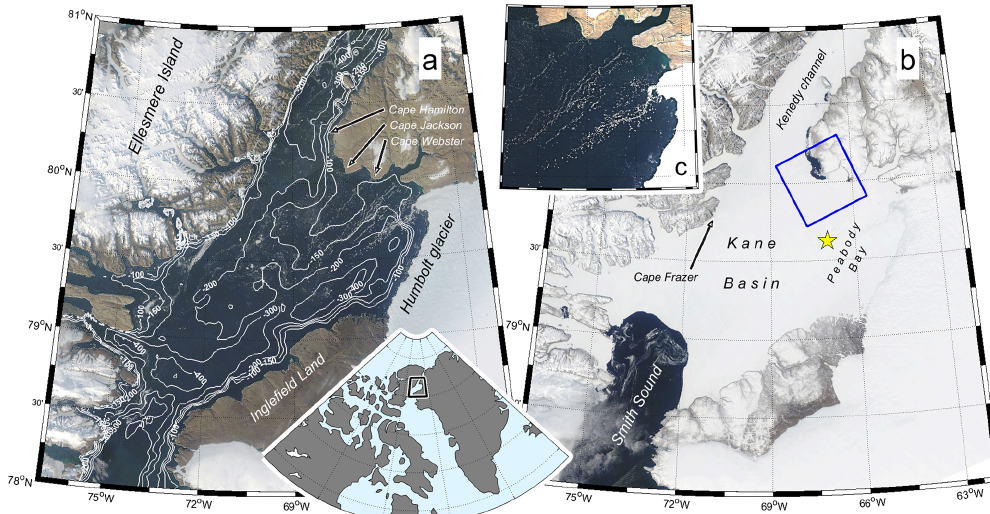
Figure 1. (a) The bathymetry of the central part of Nares Strait with contours corresponding to 100, 150, 200, 250 and 300m isobaths overlaying on the true-color MODIS imagery from NASA Worldview. (b) The MODIS image of the sensible polynya at Cape Jackson on 6 June 2021. The blue square borders a region shown in Fig. 2, and the yellow star shows the position of ERA-5 reanalysis data used in the ice growth model. (c) The high-resolution Sentinel-2 image showing the chains of grounded icebergs in the northern Peabody Bay on 8 September